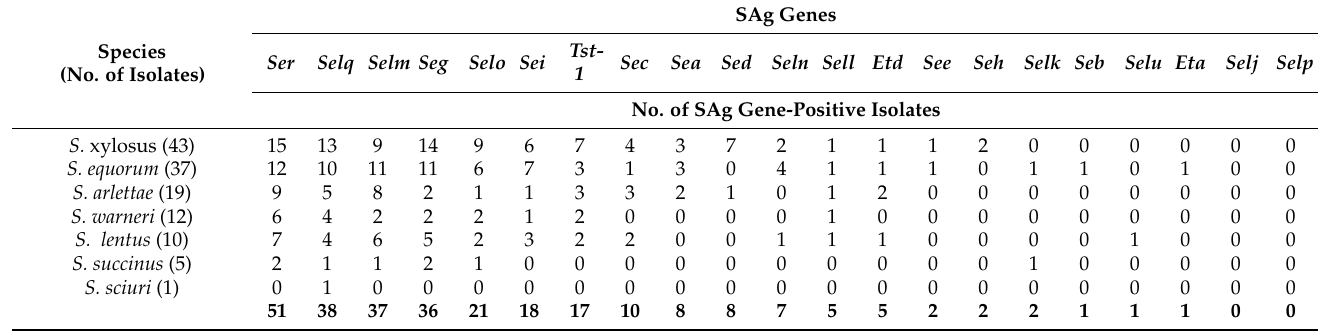
Table 5. Prevalence of superantigen (SAg) genes among Staphylococcus